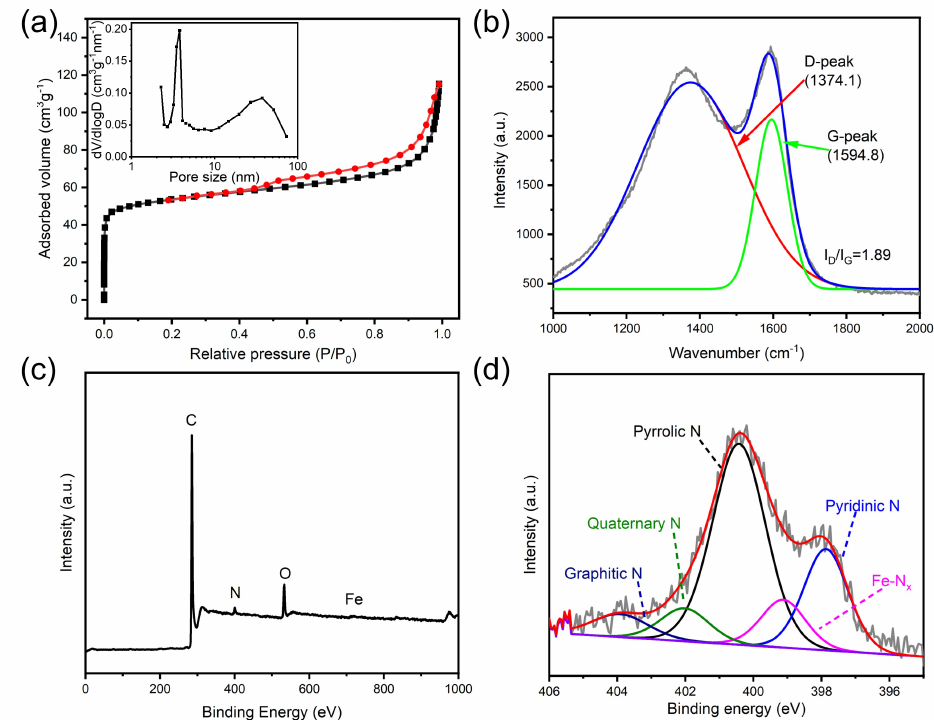
Figure 2. ( a ) N 2 adsorption–desorption isotherm (inset: pore size distribution), ( b ) Raman spectrum, ( c ) XPS survey scan spectrum and ( d ) the corresponding high-resolution N 1s spectrum of the SA-Fe@NC 800